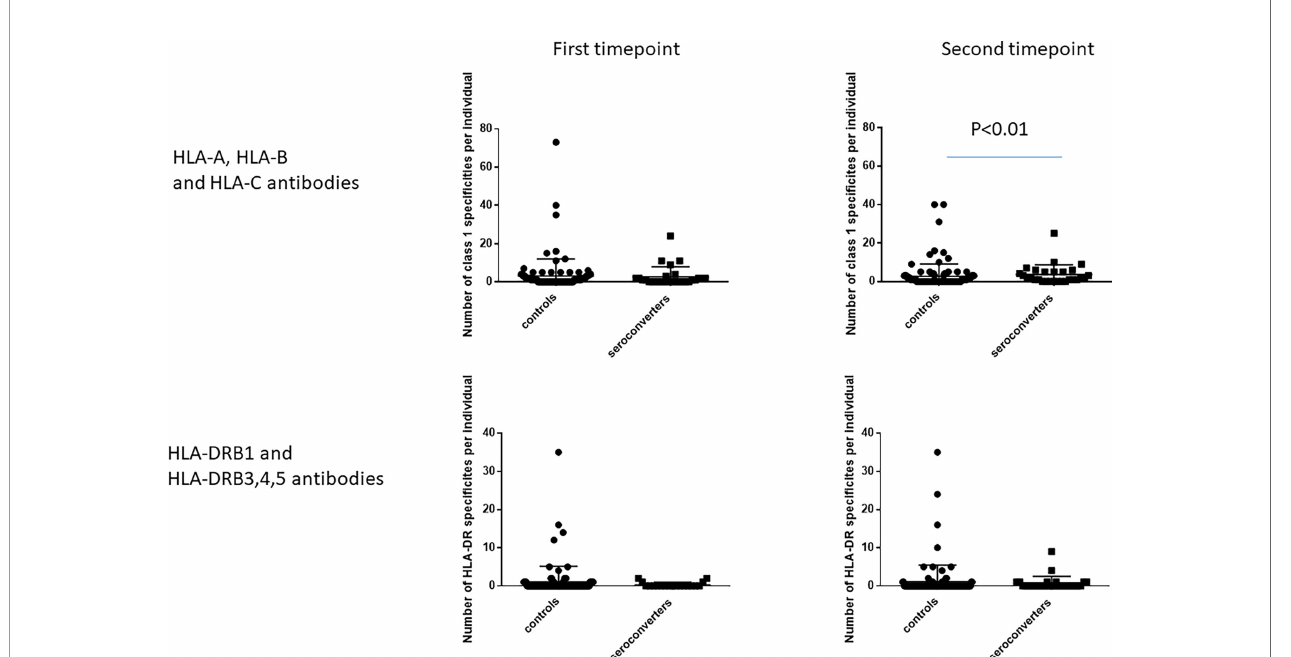
FIGURE 5 | Number of HLA antibody speci fi cities per individual, at the fi rst and second timepoints. The left hand graphs show HLA-A, HLA-B and HLA-C antibody speci fi cities. The right hand graphs show HLA-DRB1 and HLA-DRB3,4,5 antibody speci fi cities. At the second timepoint, HIV-seroconverters had a median of two antibody speci fi cities per person compared with highly exposed persistently seronegative controls who had a median of one antibody speci fi city per person. There was no other signi fi cant difference